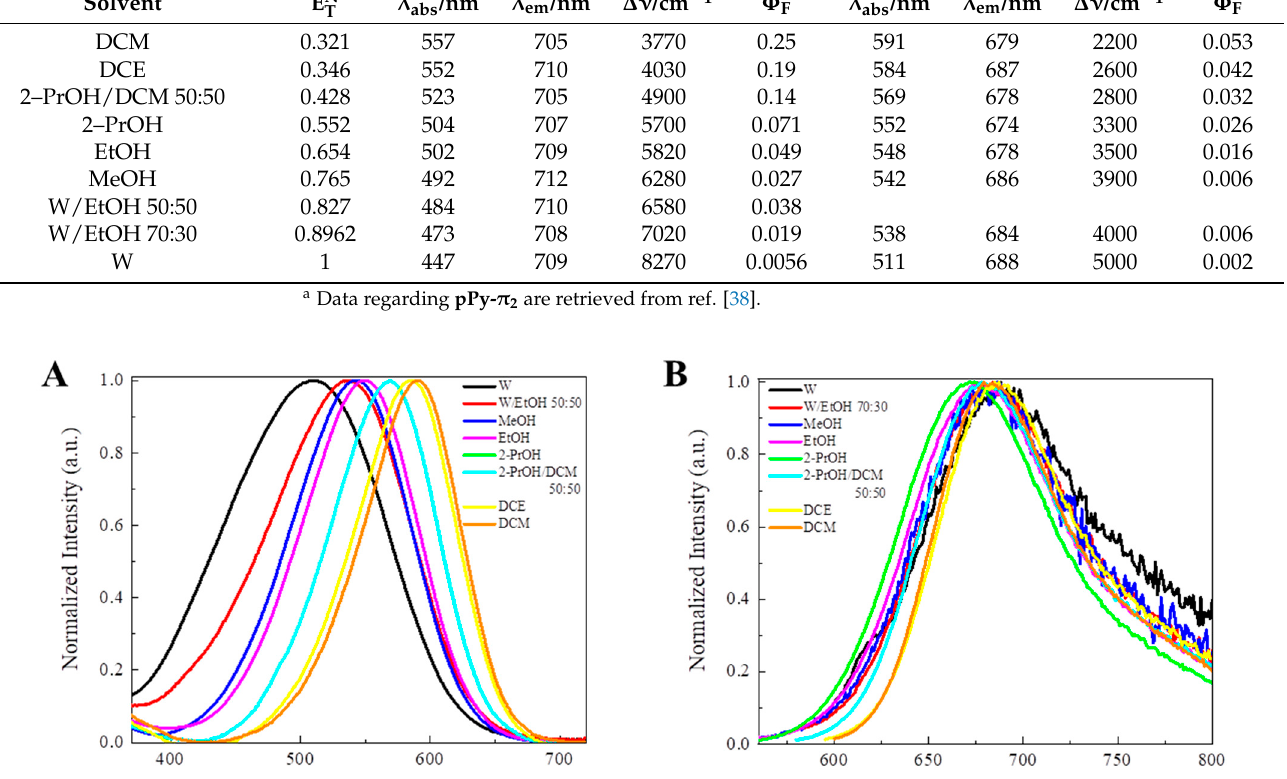
Table 1. Spectral and photophysical properties of the investigated compounds in solvents of dif- ferent polarity (E N ), absorption maximum ( λ abs ), emission maximum ( λ em ), Stokes shift ( ∆ ν ), and T fluorescence quantum yield ( Φ F ). pPy- π 2 a pQ- π 2